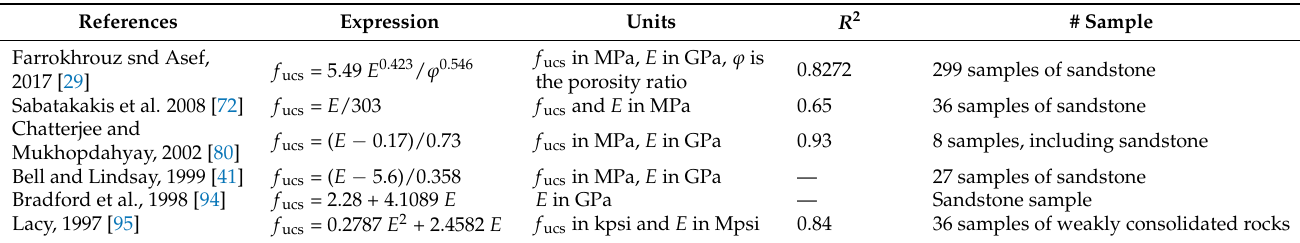
Table 9. Correlations between UCS and elastic modulus.